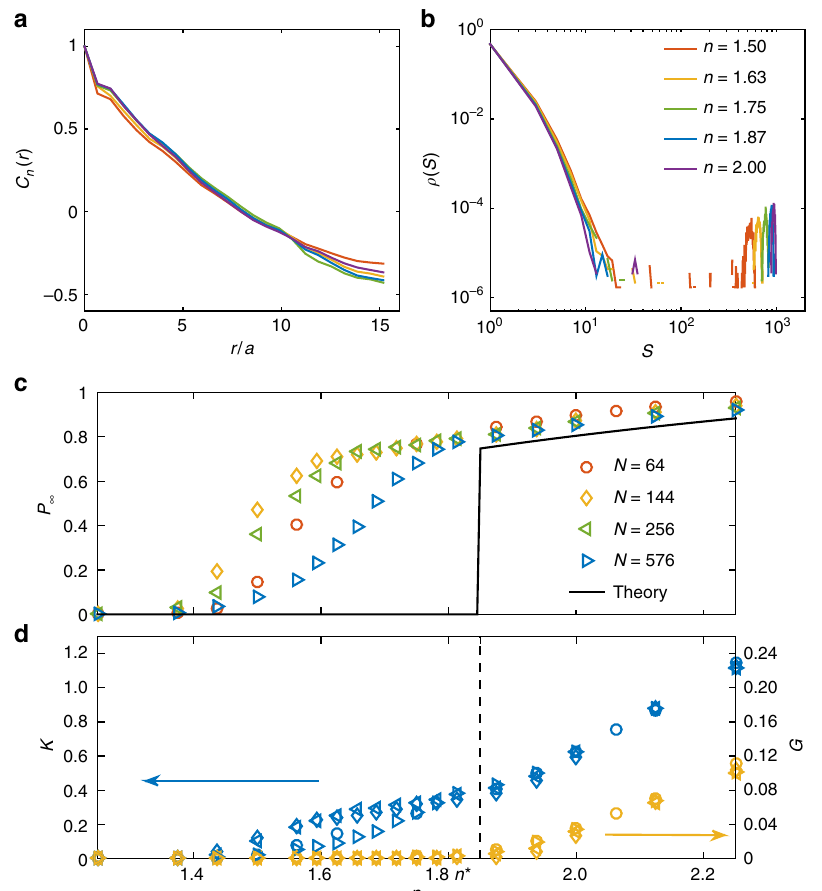
D (cid:6) (cid:7) for / n ð 0 Þ 2